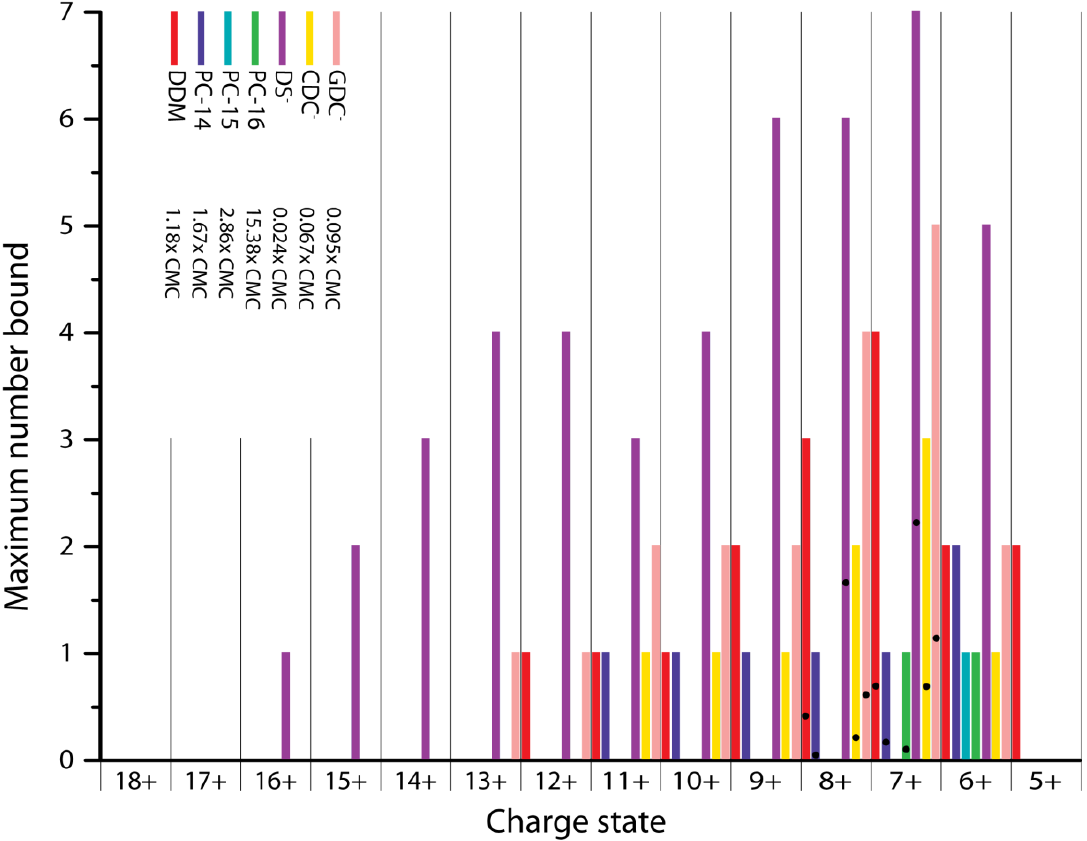
Figure 5. Comparison of the number of detergents bound per charge state and detergent when the detergent concentration is fixed at 0.20 mM (1:20 protein:detergent ratio).